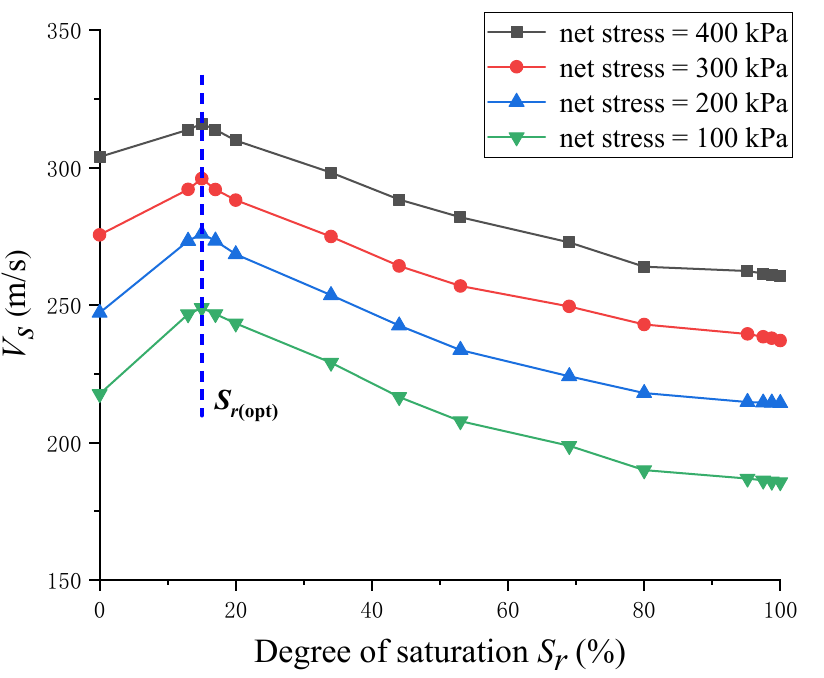
Figure 4. Variation in the S-wave velocity with the degree of saturation at different net stresses. Figure 5 shows the P-wave variation curves with saturation for the silty-fine sand, including the measured and theoretical predicted values (The input frequency of P-wave was 20 kHz). Soil can be regarded as a porous medium. If no relative movement occurs between the pore fluid and solid particles, the elastic wave velocities can be theoretically expressed as a function of the effective elastic moduli of soil at a given saturation degree [21]. For the P-wave and S-wave, the velocity V p and V s can be described in terms of the effective bulk modulus of the soil K , effective shear modulus of the soil G , and density of the soil ρ , as shown in Equations (5) and (6); while K is determined using Equation (7) [40]: